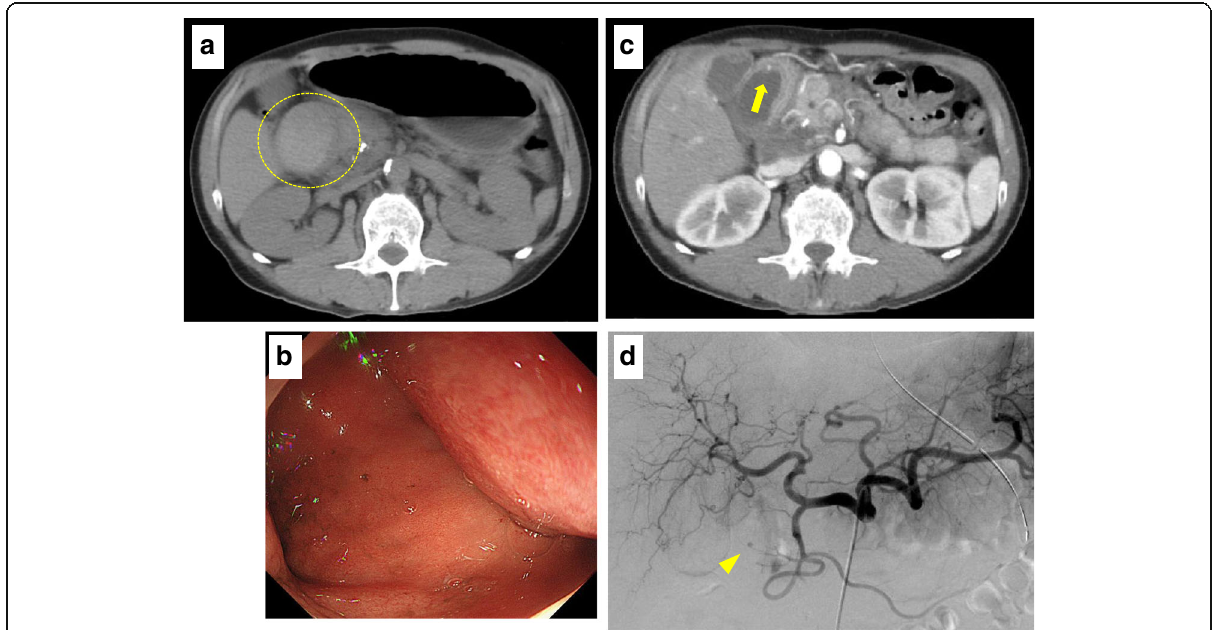
Fig. 1 a Plain abdominal computed tomography (CT) showed a cystic lesion of 7 cm in size in the lumen near the second part of duodenum. The cystic lesion showed high density inside. b Gastrointestinal endoscopy revealed that the lumen of the duodenum was deformed by a submucosal tumor-like mass. Active bleeding was not seen in the lumen of the duodenum. c Contrast-enhanced CT demonstrated a high-density spot on the wall of the cystic lesion (yellow arrow). d A pseudoaneurysm was identified in the branch of the anterior superior pancreaticoduodenal artery (ASPDA) by angiography (yellow